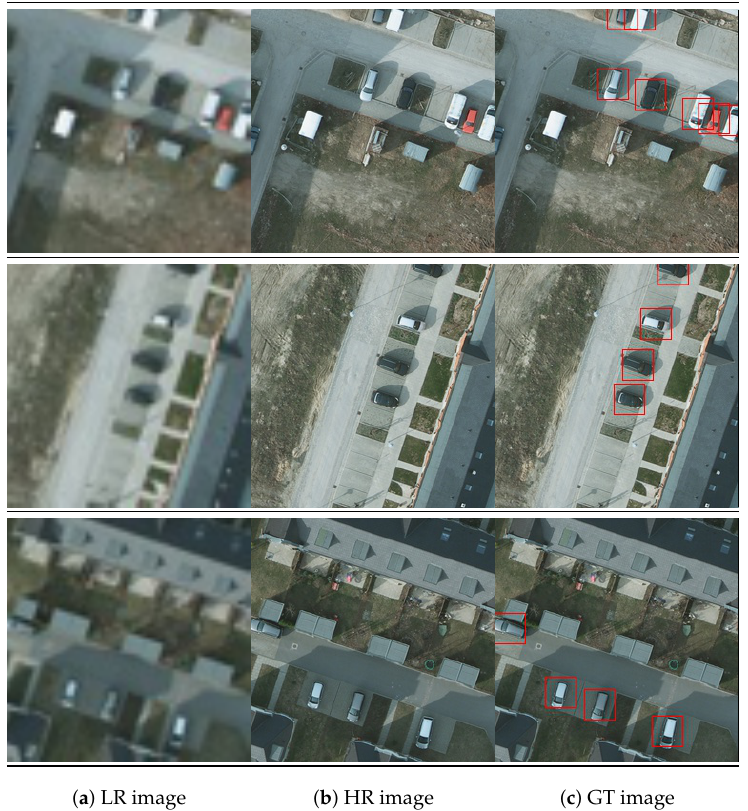
Figure 6. COWC (car overhead with context) dataset: LR-HR (low-resolution and high-resolution) image pairs are shown in ( a , b ) and GT (ground truth) images with bounding boxes for cars are in ( c